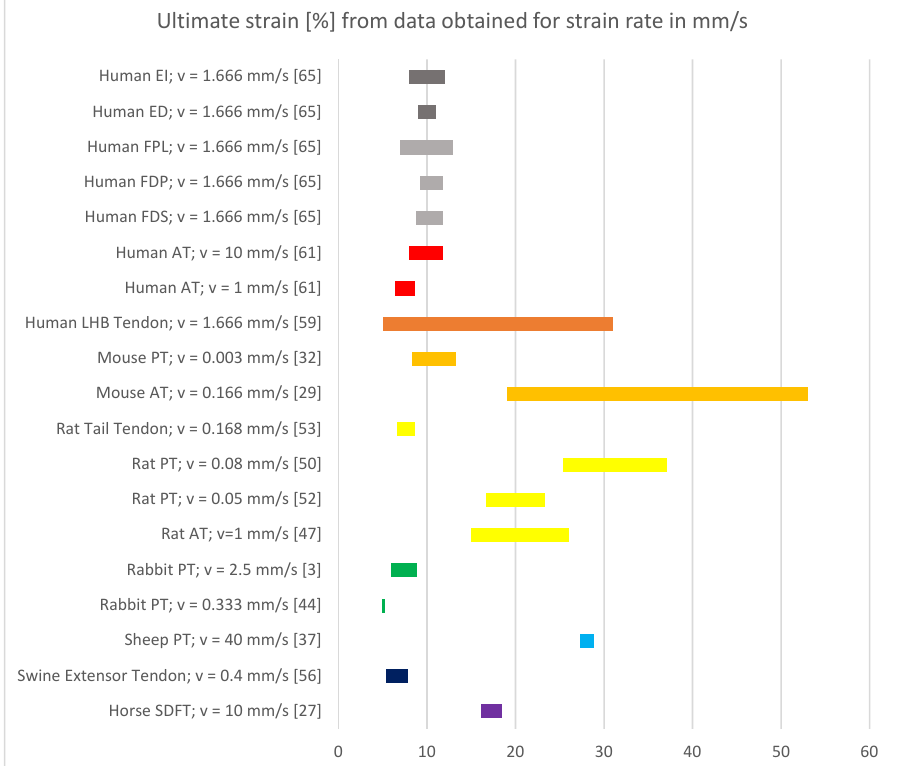
Figure 4. Ultimate strain for the considered animal species (mm/s).